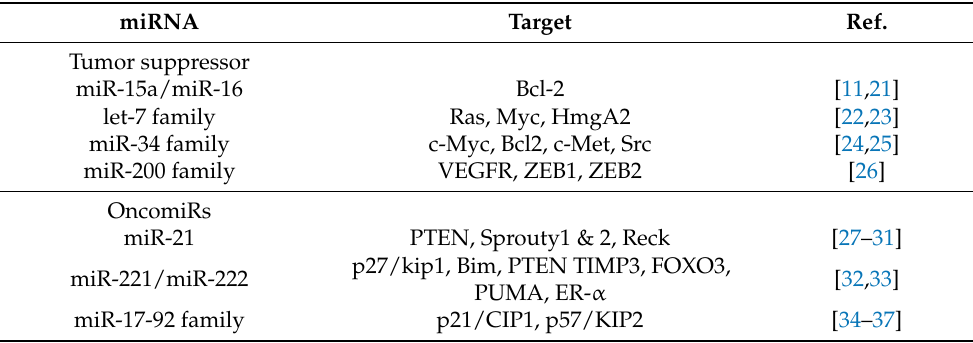
Table 1. A schematic overview of oncomiRs and tumor-suppressor